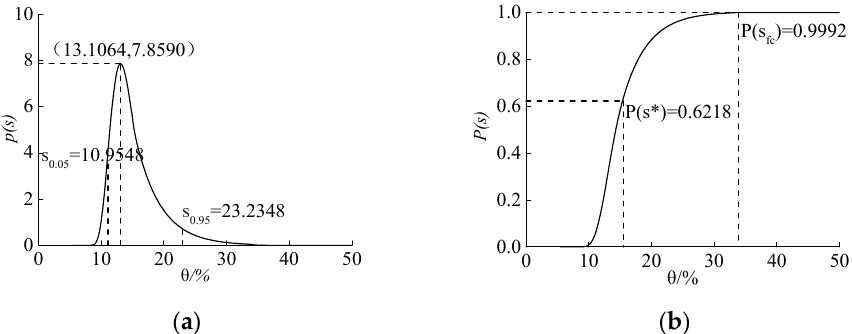
Figure 4. PDF ( a ) and CDF ( b ) of soil moisture in the calibration period. ( a ) PDF of soil moisture; ( b ) CDF of soil moisture.